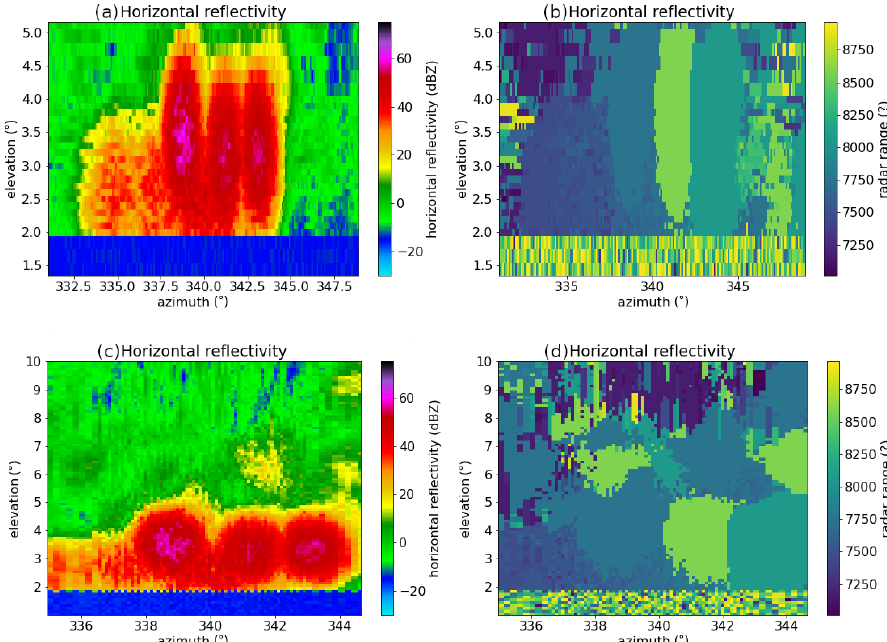
Figure 5. Fixed-range span plots of the maximum retrieved horizontal reflectivity Z H from the PPI (a) and RHI (c) scan sequences are shown. The axes indicate the azimuth and elevation angles. The subplots (b) and (d) show the range gates from both scan sequences, respectively, where the maximum Z H occurred. Be aware that azimuth and elevation span is different for the PPI- and RHI-based fixed-range span plots. The former go from 331 to 349 ◦ in azimuth and from 2 to 5 . 1 ◦ in elevation and the latter from 335 to 344 . 6 ◦ in azimuth and from 2 to 10 ◦ in